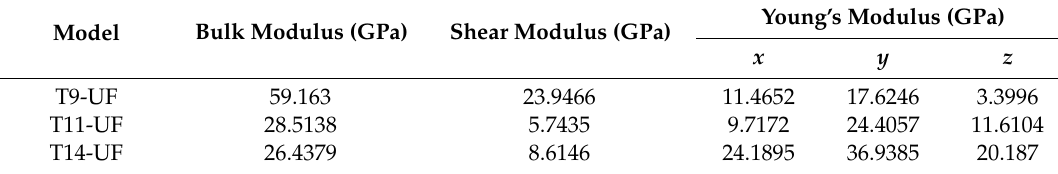
Table 1. The bulk modulus, shear modulus and elastic modulus of the three